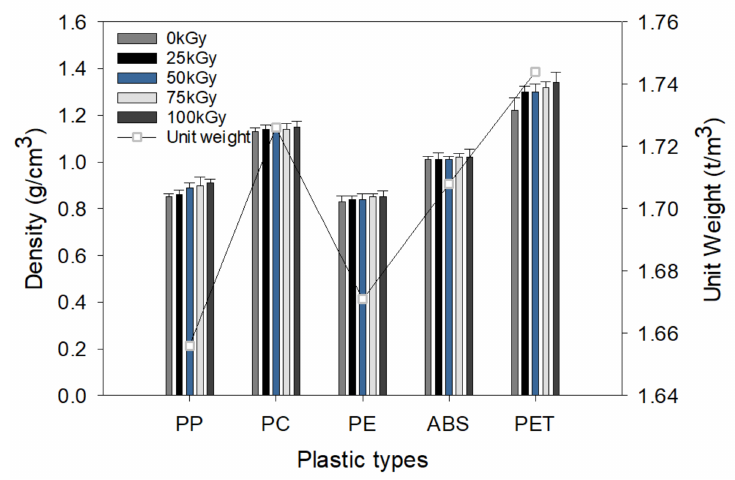
Figure 19. Variation in density and unit weight according to gamma irradiation.